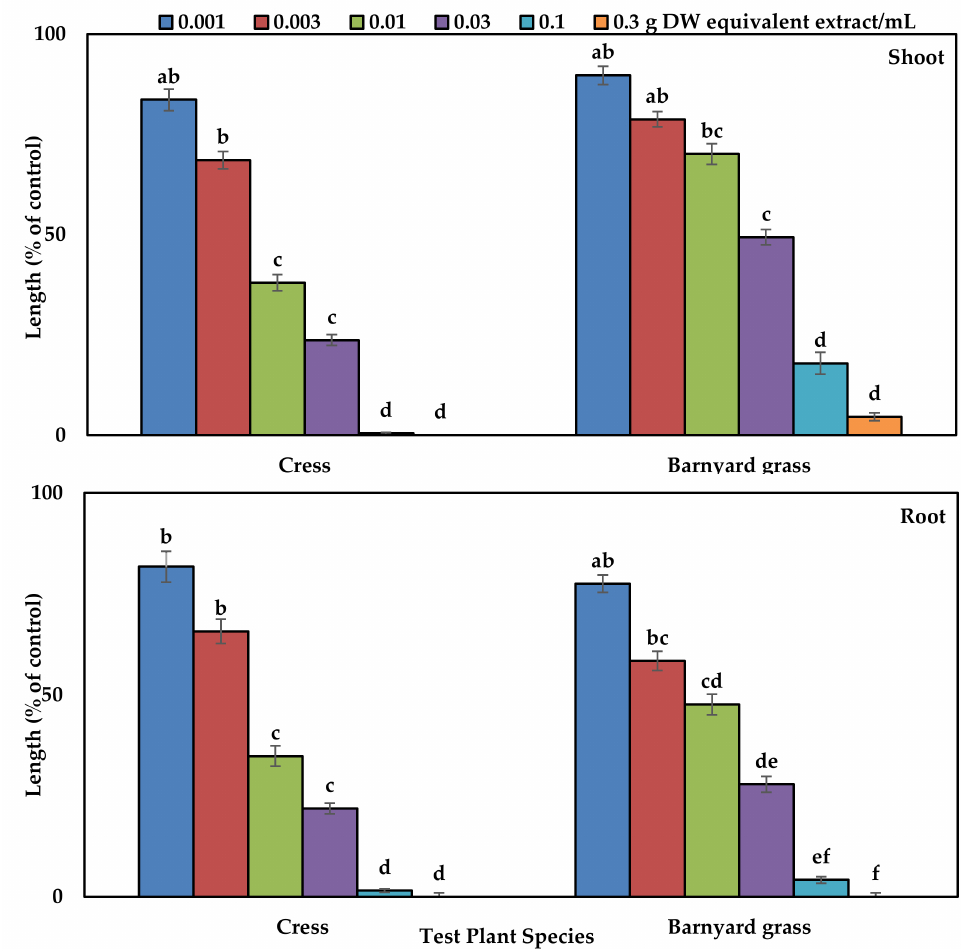
Figure 1. The phytotoxic potential of Elaeocarpus floribundus leaf (aqueous methanol) extracts against the seedling growth of cress and barnyard grass at various concentrations. The mean ± standard error was determined from two different experiments (replicated thrice; seedlings per treatment were 10, and total n = 60). Various letters signify significant differences according to Tukey’s HSD test at the probability level of 0.05. Table 1. The concentrations required for 50% growth inhibition (I 50 value) of the cress and